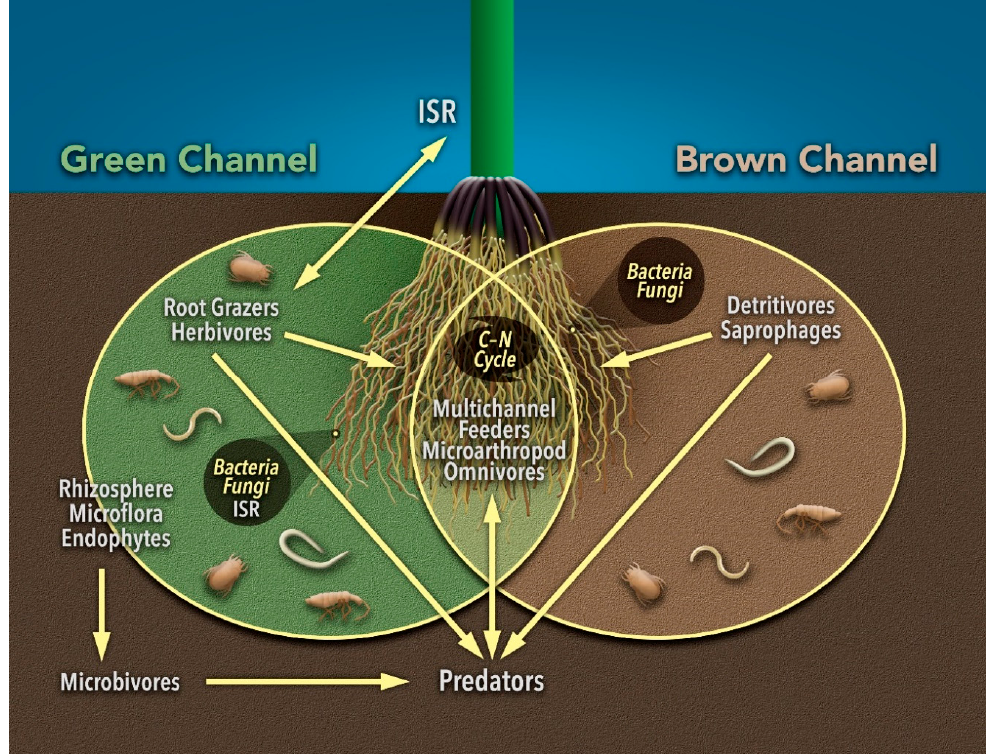
Figure 1. Carbon originates from primary producers either from root exudates of living plants (green channel) or degradation of detritus (brown channel). Collectively, these channels link above- and below-ground resource pools. Abbreviations defined as induced systemic resistance (ISR), carbon (C), and nitrogen (N). Figure credit: N. Sloff.